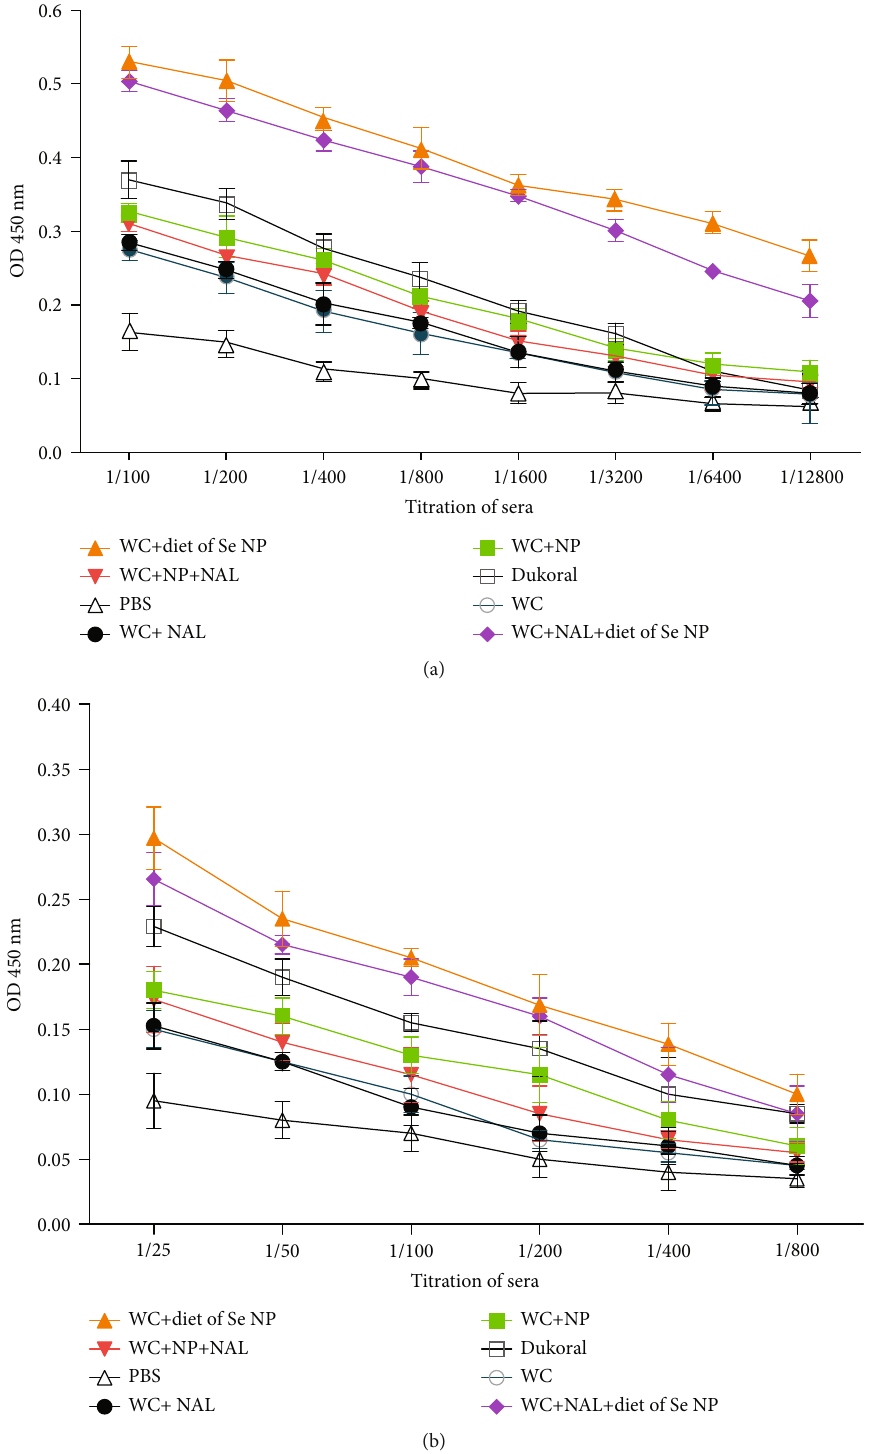
Figure 7: (a) IgA titer in serum of di ff erent mice on day 42. (b) IgA titer in saliva of di ff erent mice on day